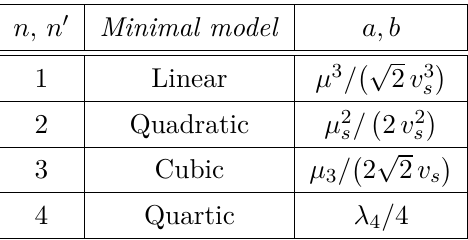
Table 2. Relation of the effective parameters a and b defined in eqs. (5.1), (5.3)–(5.4) and the explicit symmetry breaking couplings in the potential for the minimal models .